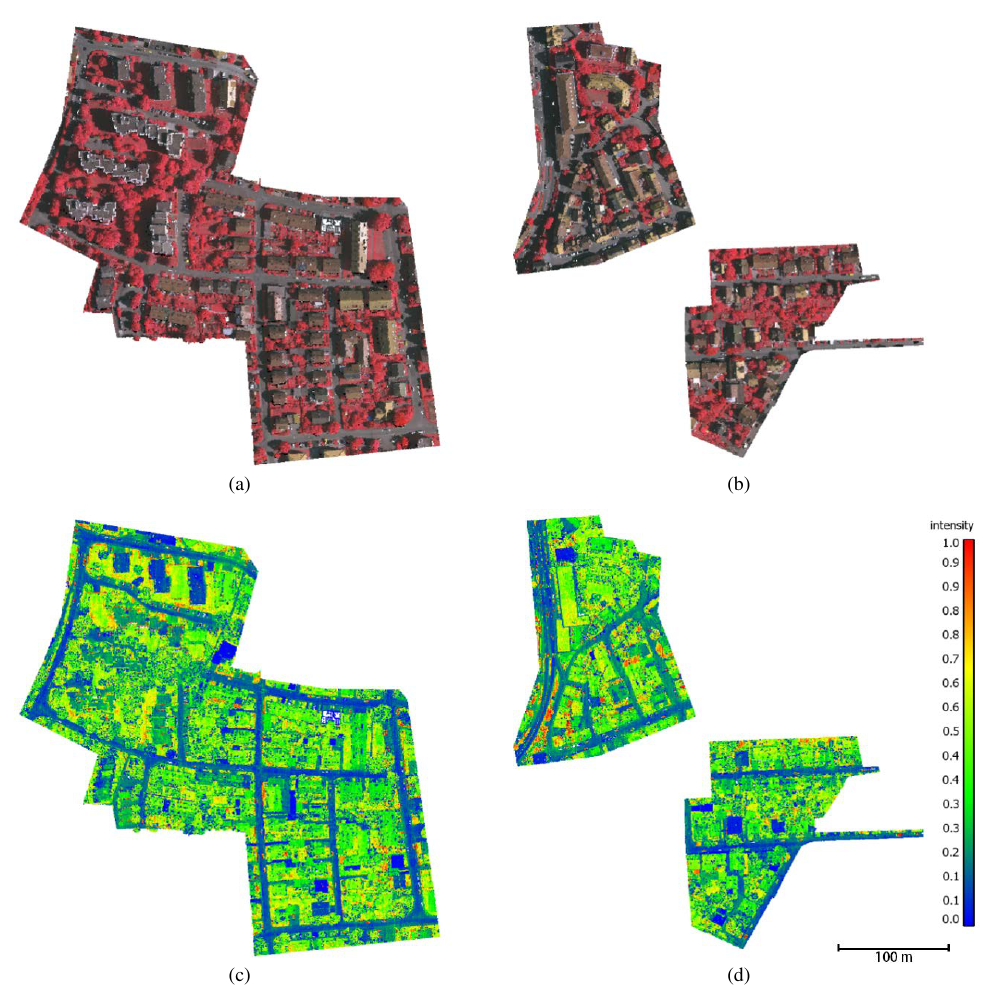
Figure 3. (a) and (b) represent the color maps (IR, R, G) of training and testing datasets, respectively, whereas (c) and (d) represent the normalized intensity maps of the two